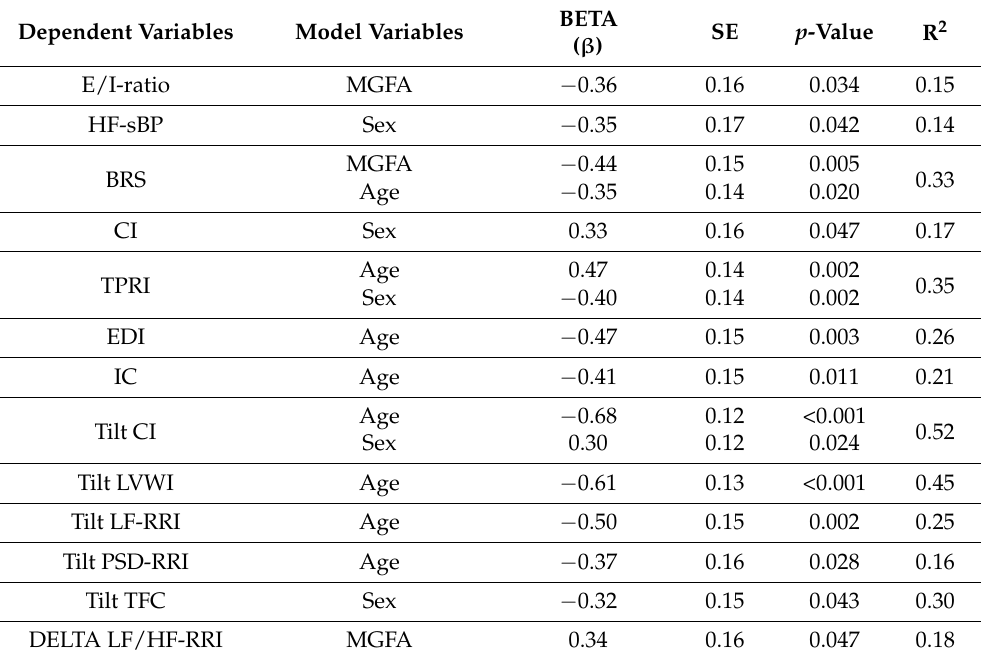
Table 3. Multivariate analysis for prediction of frequency domain and cardiac and autonomic variables by clinical